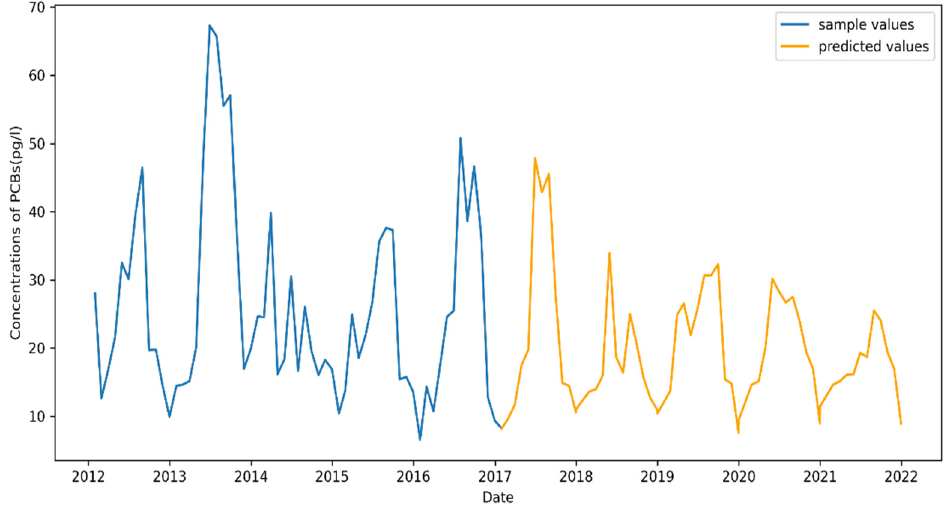
Figure 11. The predicted concentration values of PCBs at Eagle Harbor in the next 5 years.